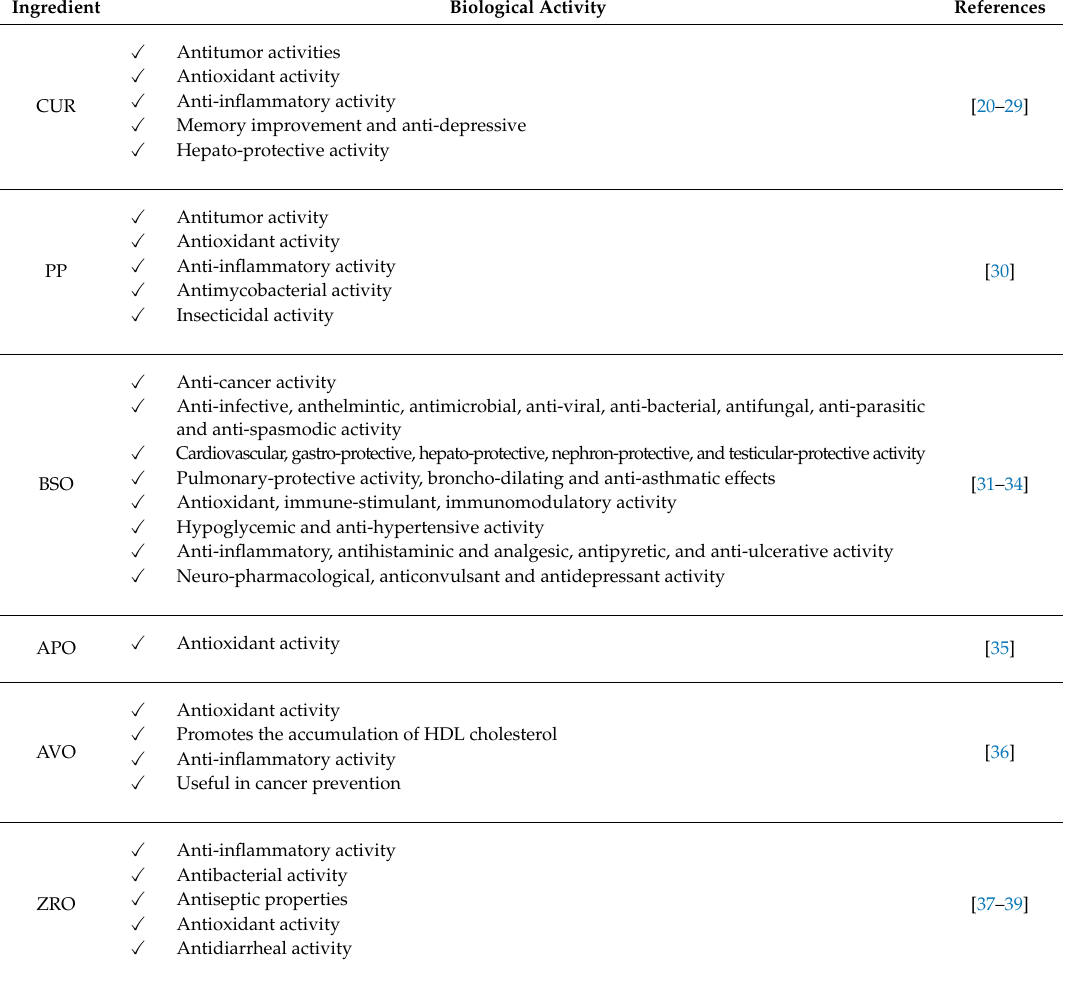
Table 1. The most significant biological and pharmacological activities of bioactive materials used in the